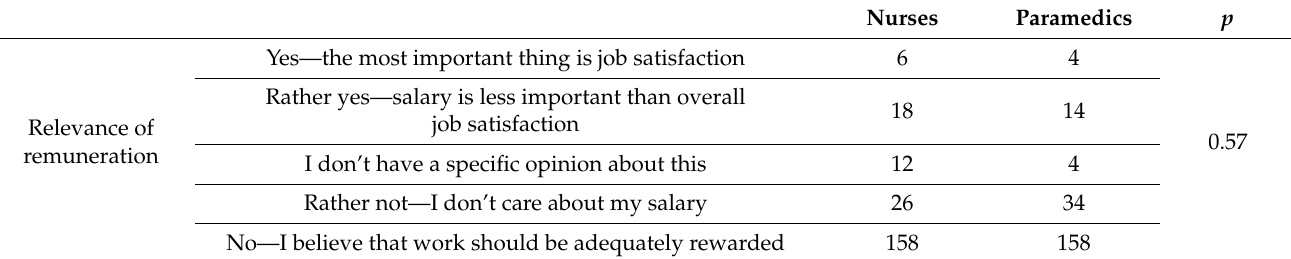
Table 10. Correlation between salary relevance for nurses and paramedics.